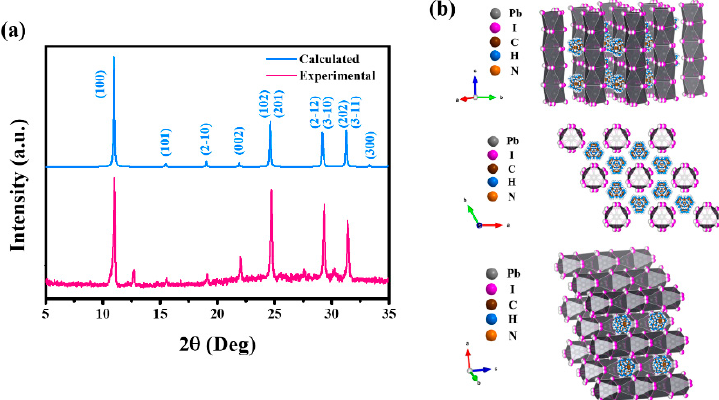
Figure 2. ( a ) XRD results of the calculated and experimental PyPbI 3 film. ( b ) Crystal structure of PyPbI 3 single crystal. More structure details of PyPbI 3 were summarized and discussed in our pre- vious work [26]. Adapted from Ref [26] with permission from The Royal Society of Chemistry.